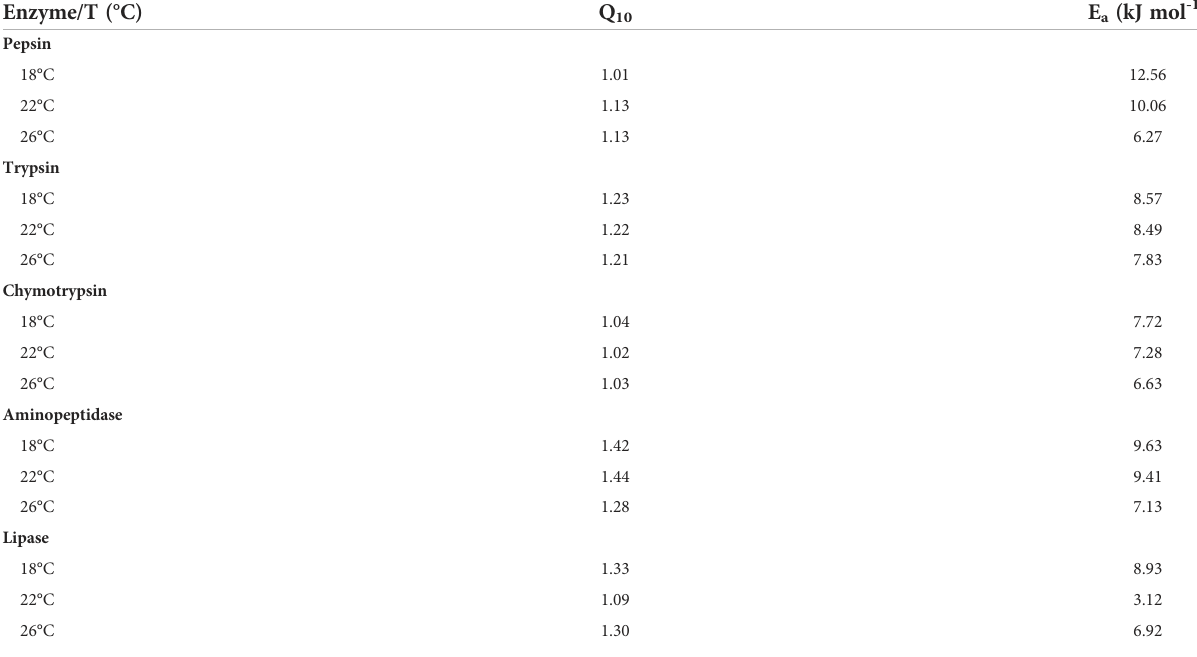
TABLE 4 Q 10 value and activation energy (E a ) for digestive enzymes of Seriola dumerili at different rearing temperatures. Enzyme/T